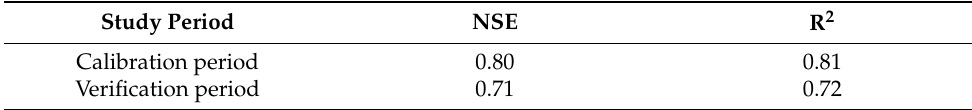
Table 7. Evaluation of the Simulation Effect of Water yield in the XRB.